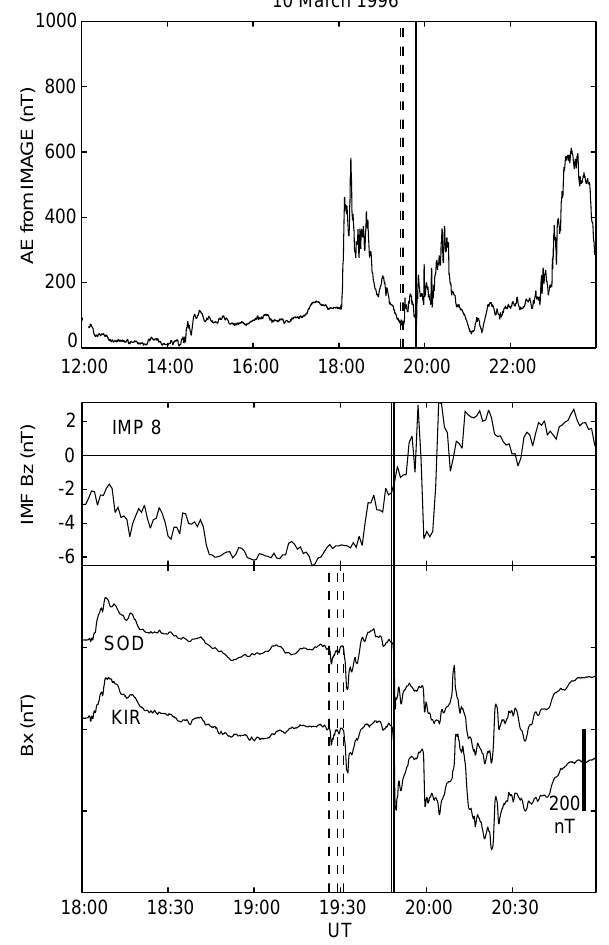
Fig. 9. Fading event on 10 March 1996: ( top panel ) local AE index computed using data from the IMAGE magnetometer chain, ( middle panel ) IMF B z in GSM coordinates recorded by IMP-8 (satellite location: X GSM from 32.7 to 33 : 0 R E , Y GSM from (cid:255) 15 : 3 to (cid:255) 15 : 6 R E , and Z GSM from 11.9 to 11 : 7 R E ), and ( bottom panel ) B x magnetograms at SOD and KIR. The vertical lines mark the fading and breakup times. The fadings before the pseudo-breakup are marked with the dashed